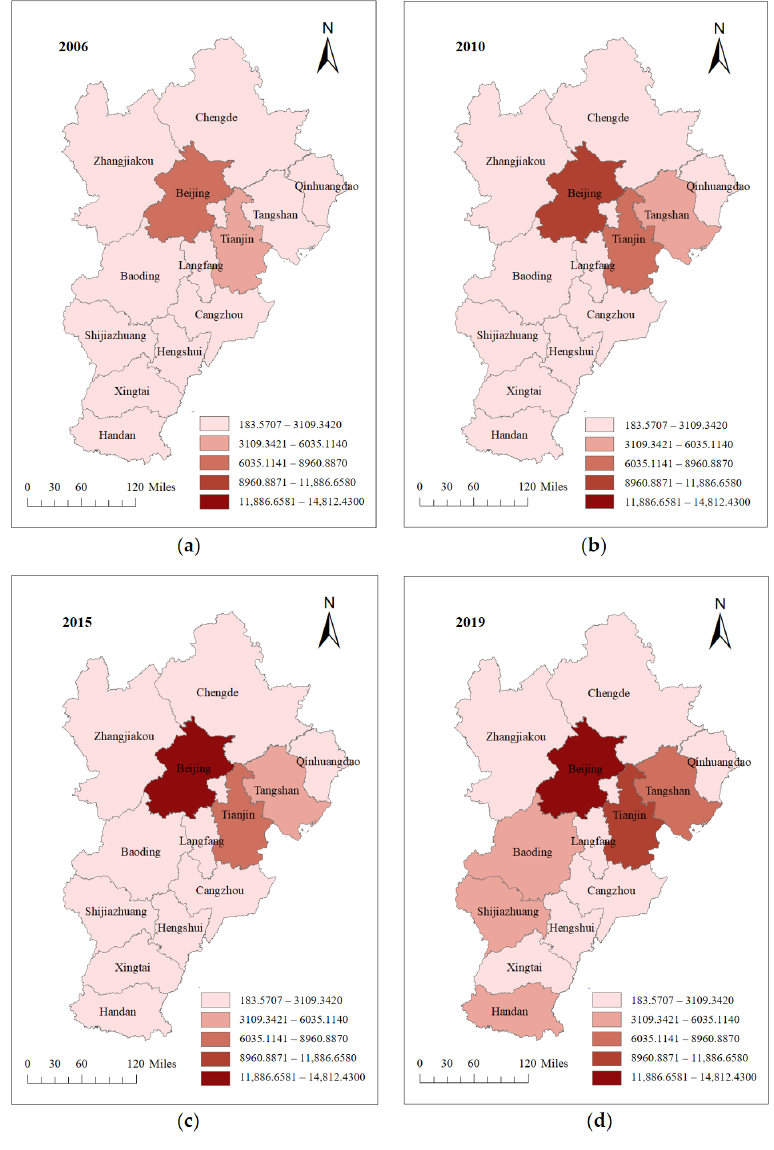
Figure 3. Spatial distribution of carbon footprints in BTH. ( a ) Spatial distribution of carbon footprints in BTH in 2006; ( b ) spatial distribution of carbon footprints in BTH in 2010; ( c ) Spatial distribution of carbon footprints in BTH in 2015; ( d ) spatial distribution of carbon footprints in BTH in 2019. Figure source: authors’ own creation. Data from the China Energy Statistical Yearbook , China Urban Statistical Yearbook and 2006 IPCC Guidelines for National Greenhouse Gas Inventories